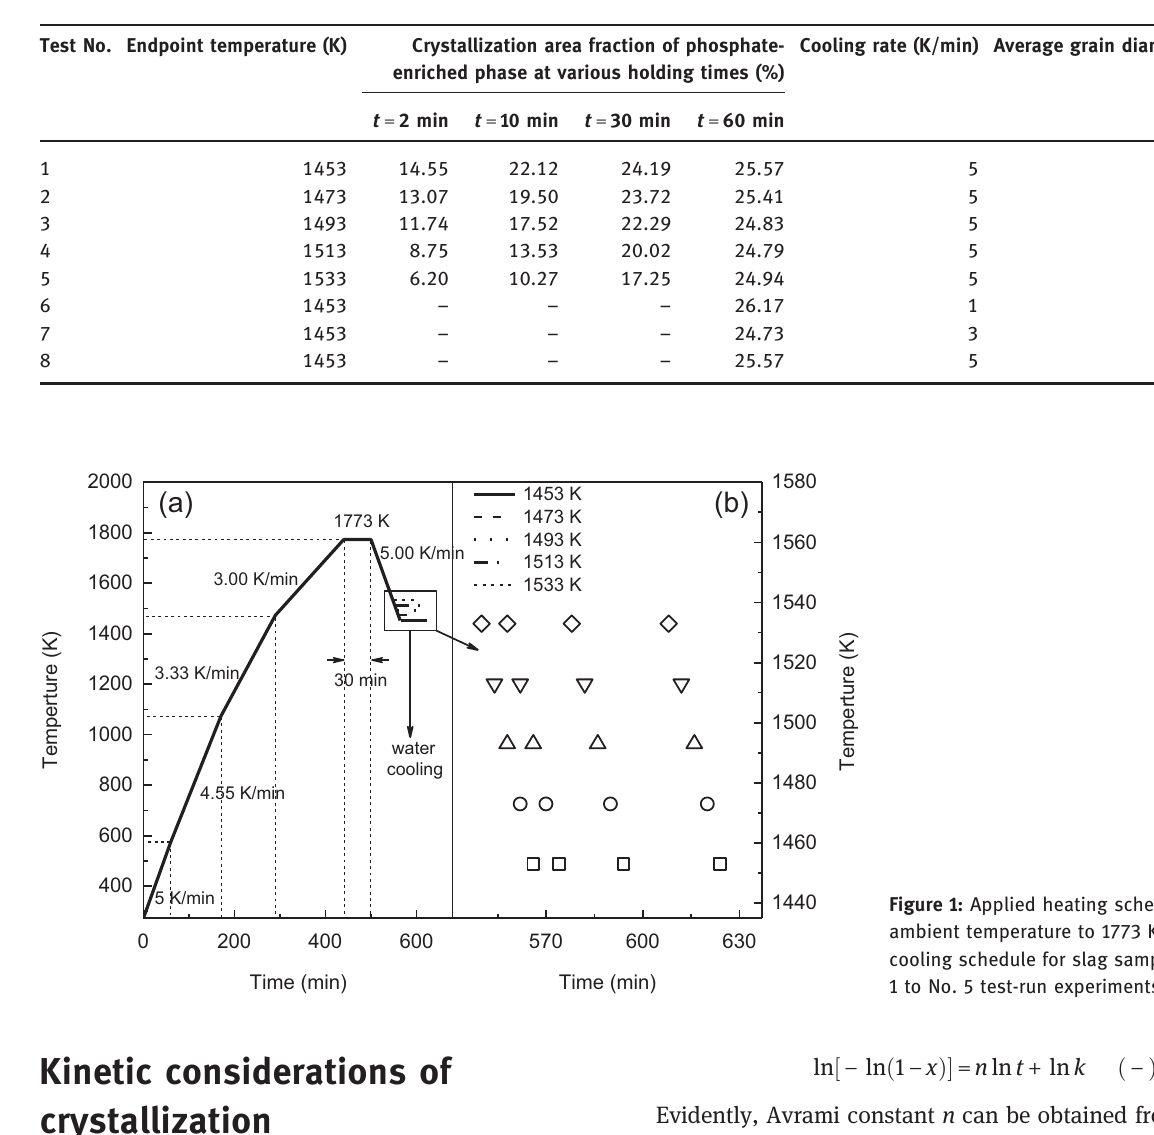
Table 1: Determined crystallization area fraction of phosphate-enriched phase of eight test-run experiments and average grain diameters of No. 6 – No. 8 test-run experiments under various cooling conditions.